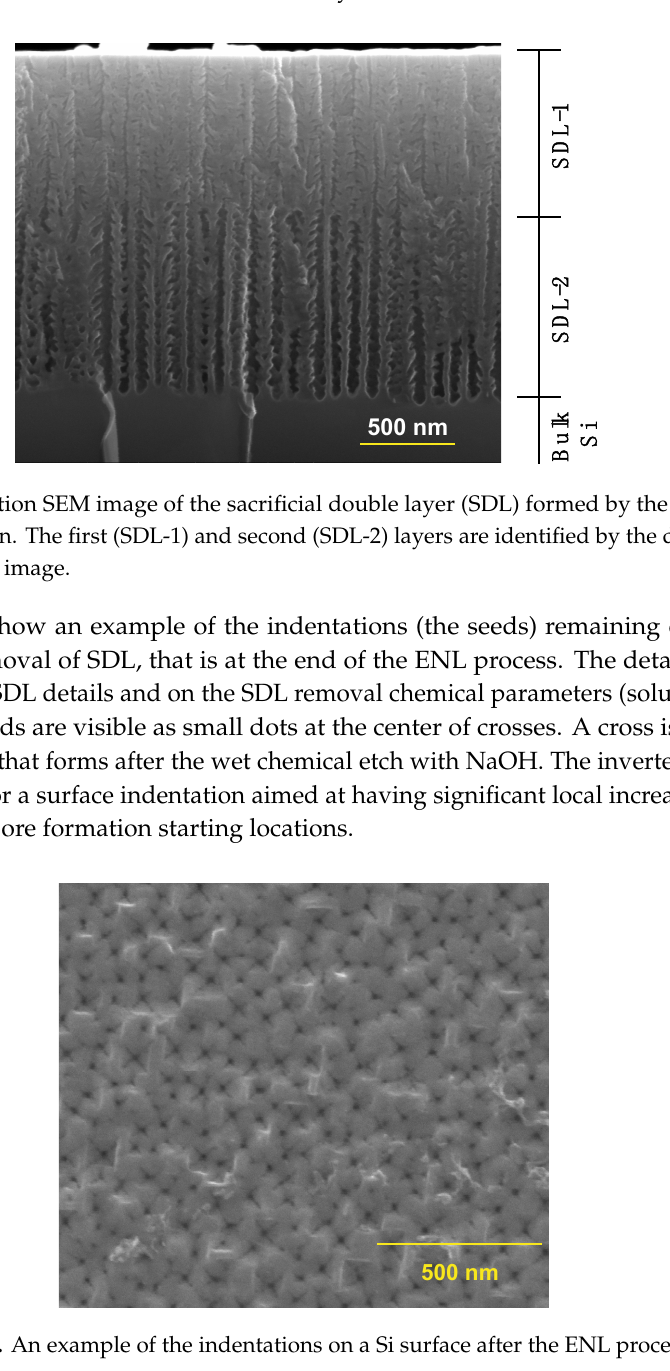
Figure 3. An example of the indentations on a Si surface after the ENL process.